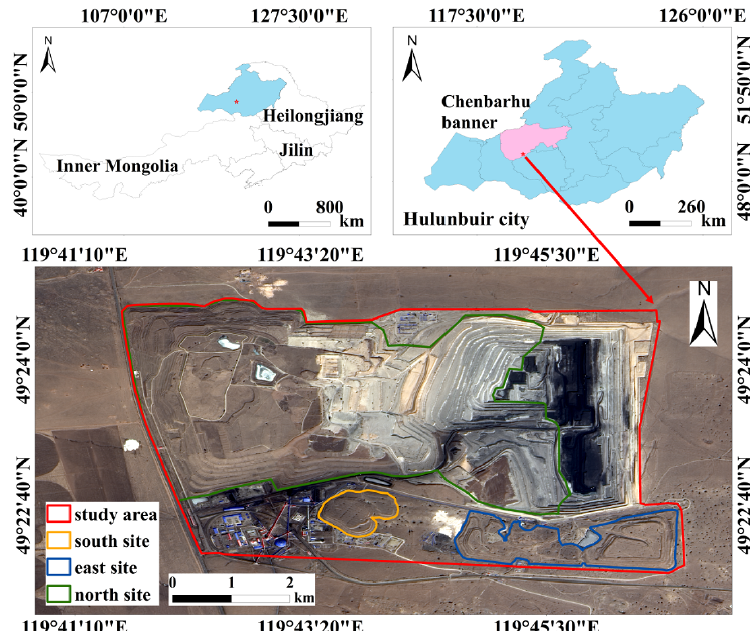
Figure 1. Location of the study area